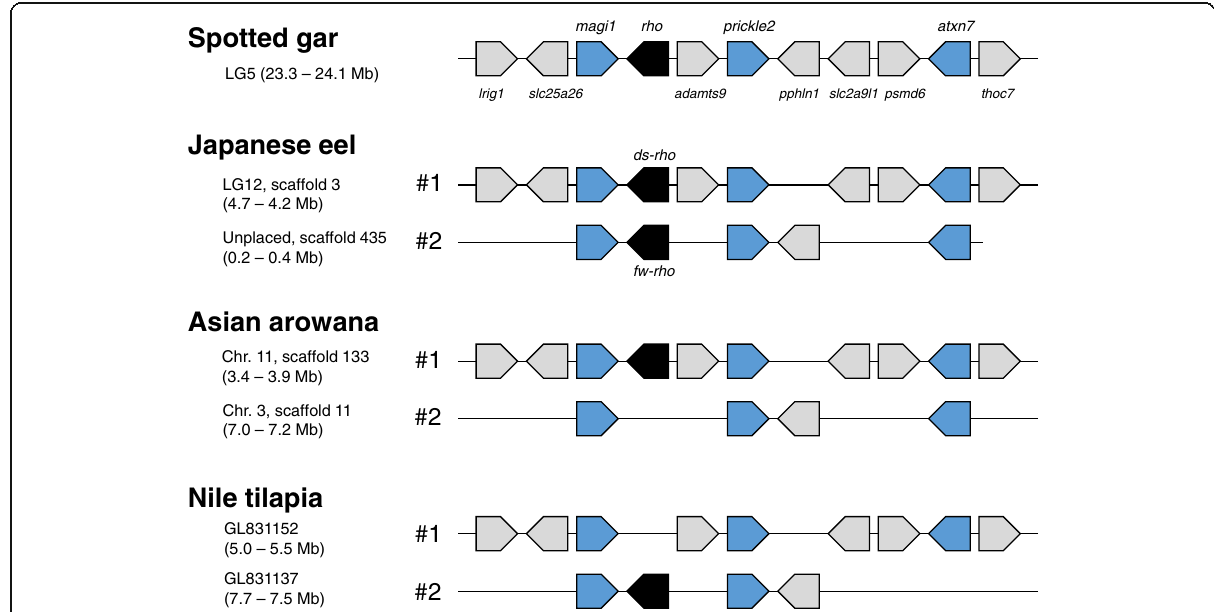
Fig. 3 Microsynteny of 11 genes including rho Rhodopsin genes are colored in black, and three pairs of paralogs present in Japanese eel and Asian arowana, magi1 , prickle2 and atxn7 , are highlighted in blue. In scaffold 435 of Japanese eel, atxn7 was predicted at the end, and thoc7 was not found in any other scaffolds. Putatively orthologous syntenies are denoted as #1 and #2,